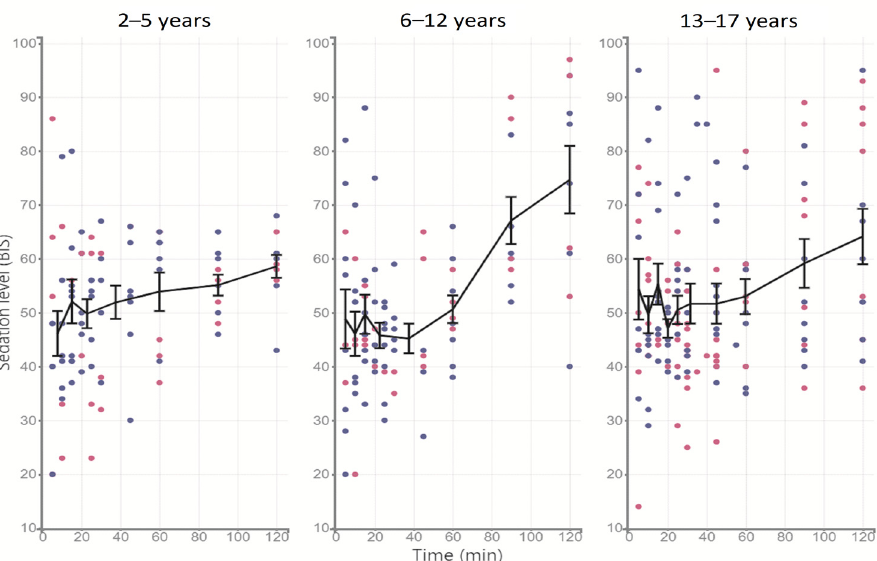
Figure 2. Temporal courses of sedation levels (BIS) distributed by age range; the line describes the arithmetic mean ± SE. Blue points indicate male patients and pink points indicate female patients.